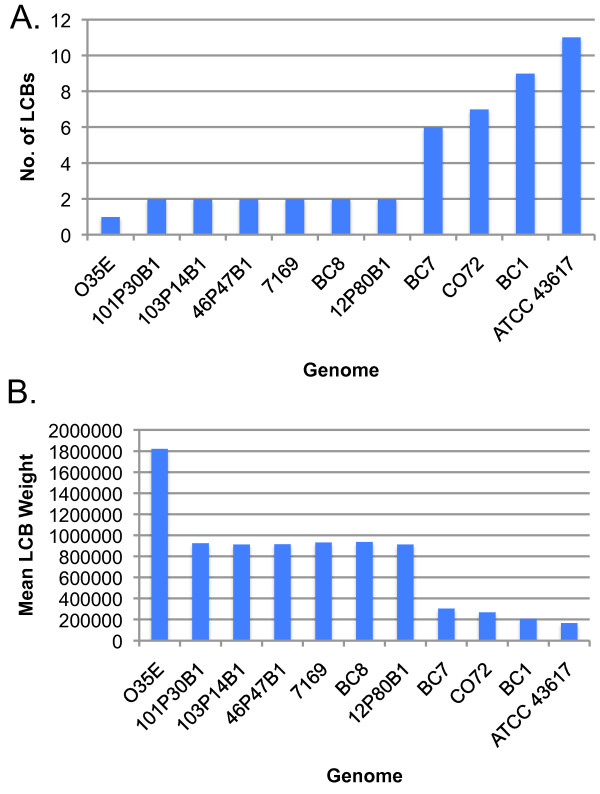
Comparison of pair-wise alignments of the eleven draft genomes to RH4. Data are plotted as the (A) number of LCBs common between each labeled genome and RH4, as well as (B) the mean of the LCB weights (as defined in [38]) present in (A).